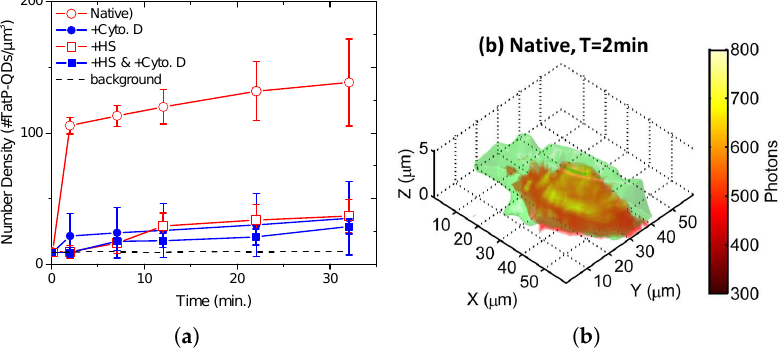
Figure 3. ( a ) time courses of cellular uptake of TatP conjugated quantum dots (TatP-QDs) (#/ µ m 3 ) in native HeLa cells (circles) and heparan sulfate (HS)-removed cells (squares). Data obtained on cells pretreated with Cyto D are presented using filled symbols. Each data point depicts the average value over 10 cells with error bars representing cell-to-cell variation; ( b ) snapshot of spatial distribution of fluorescent signal in a living HeLa cell at 2 min after transactivator of transcription peptide (TatP) administration. Cell surface deduced from optical sectioning phase contrast images is shown in